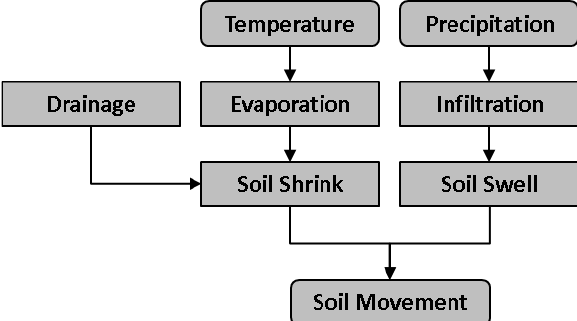
Figure 1. Mechanism of soil movement influenced by geologic and hydrologic factors.